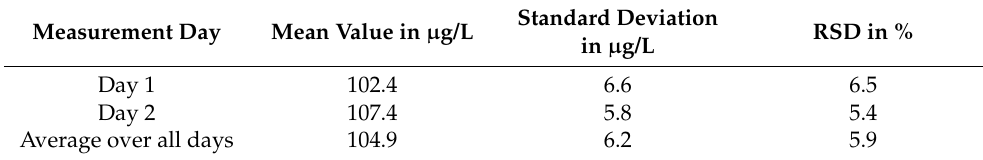
Table 4. Mean values, standard deviations, and relative standard deviations (RSD) as calculated from the voltammetric investigation of six independent Milli-Q water test samples (three per day) each spiked with 100.0 µ g/L platinum as measured with a bismuth film on solid state glassy carbon